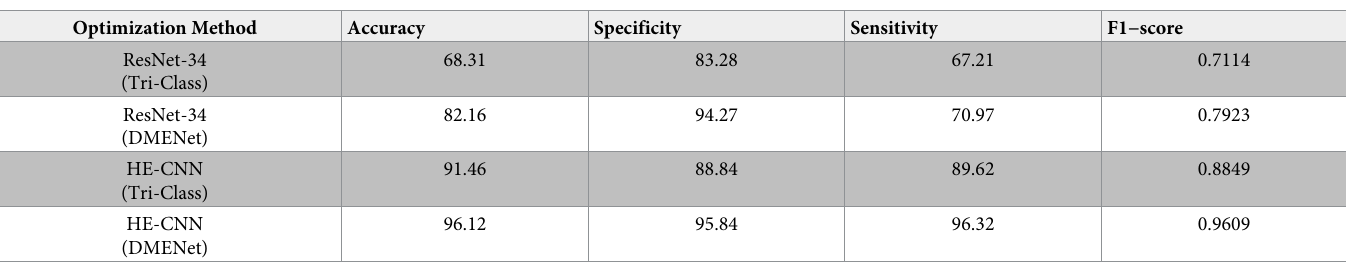
Table 8. Results of DMENet v/s tri-class